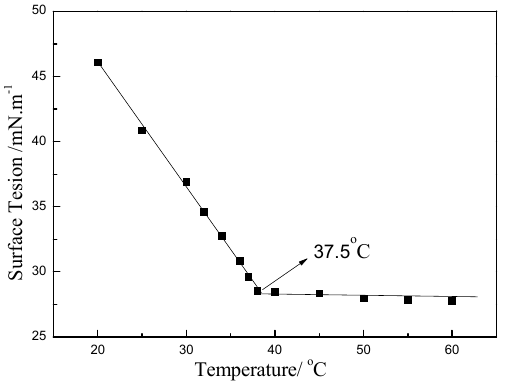
Figure 2. Surface tension curve of P2 aqueous solution (0.5 mg·mL − 1 , pH 7) versus temperature.